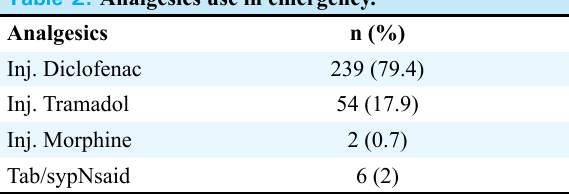
Table 2. Analgesics use in emergency.